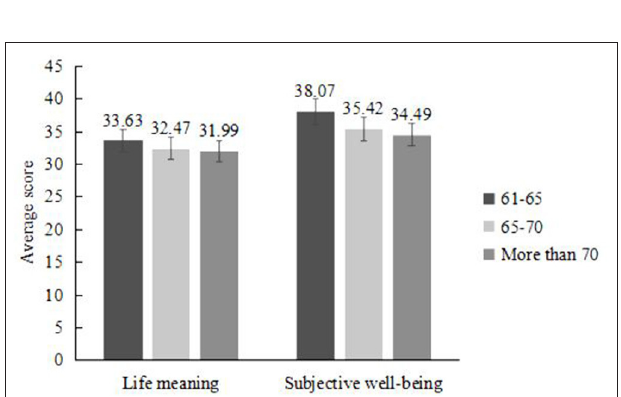
FIGURE 2 | Comparison of scores of different scales among older people of different ages. Age differences existed in the subjective well-being of older people, but not in the life meaning. The subjective well-being of older individuals steadily declines with rising age. The data on the bar chart are averages, and the vertical line represents the standard